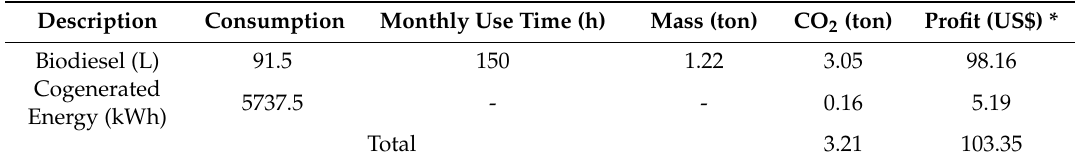
Table 7. Accounting for carbon credits associated with smart grid project.